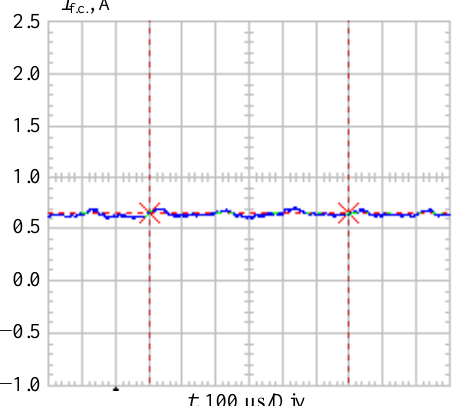
Fig. 10. Current of the fuel cell in the case when load is powered only by the fuel cell.